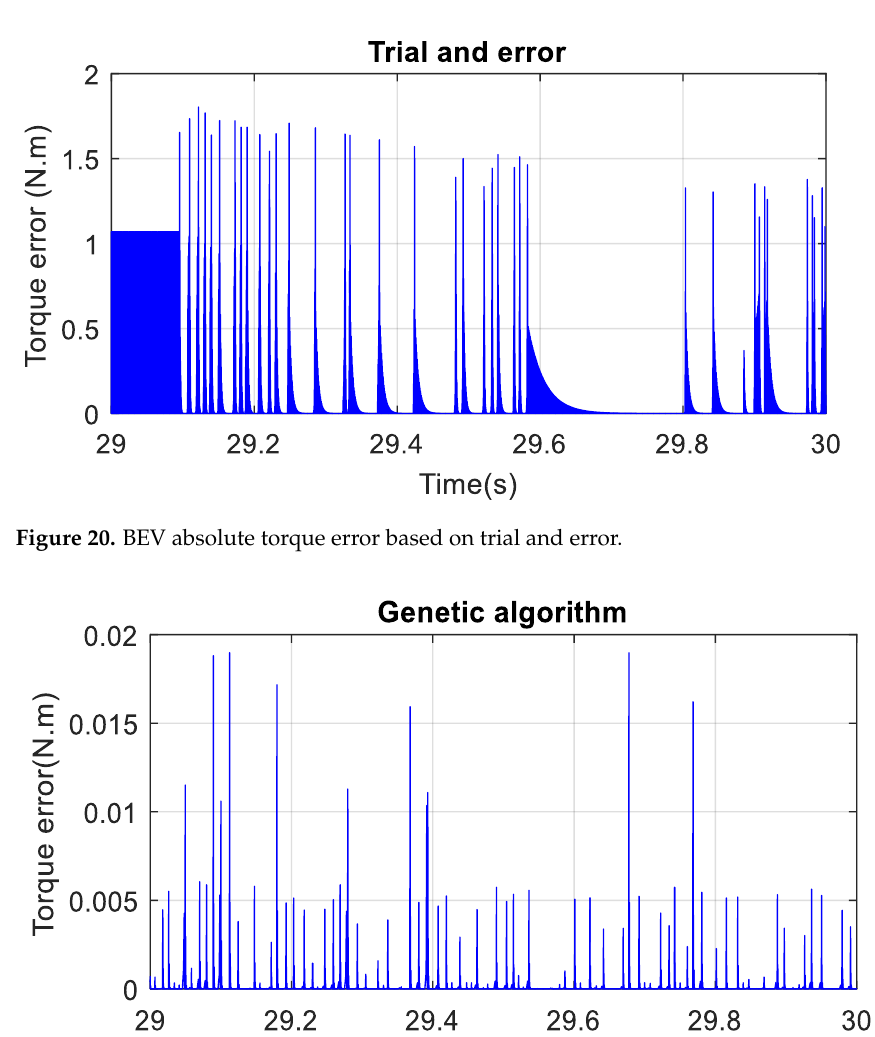
Figure 22. BEV absolute torque error with PSO.